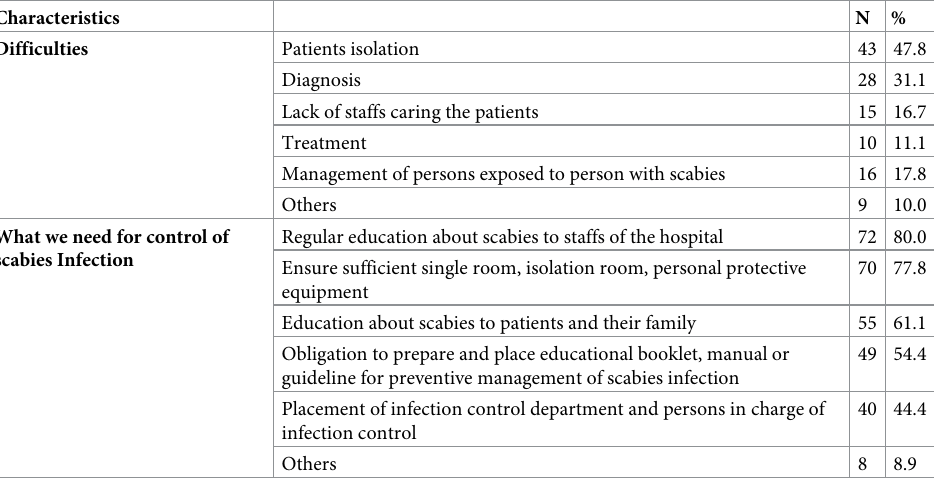
Table 8. Difficulties in infection control and measures for managing scabies (multiple responses) (N = 90).